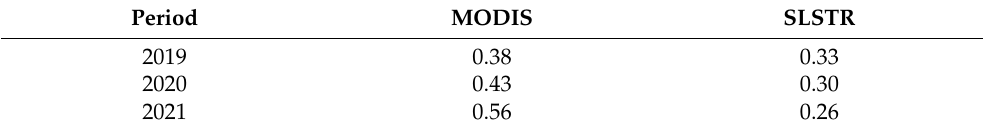
Table 3. Data Coefficient (DC) Values after validation of MODIS and SLSTR burned area maps.